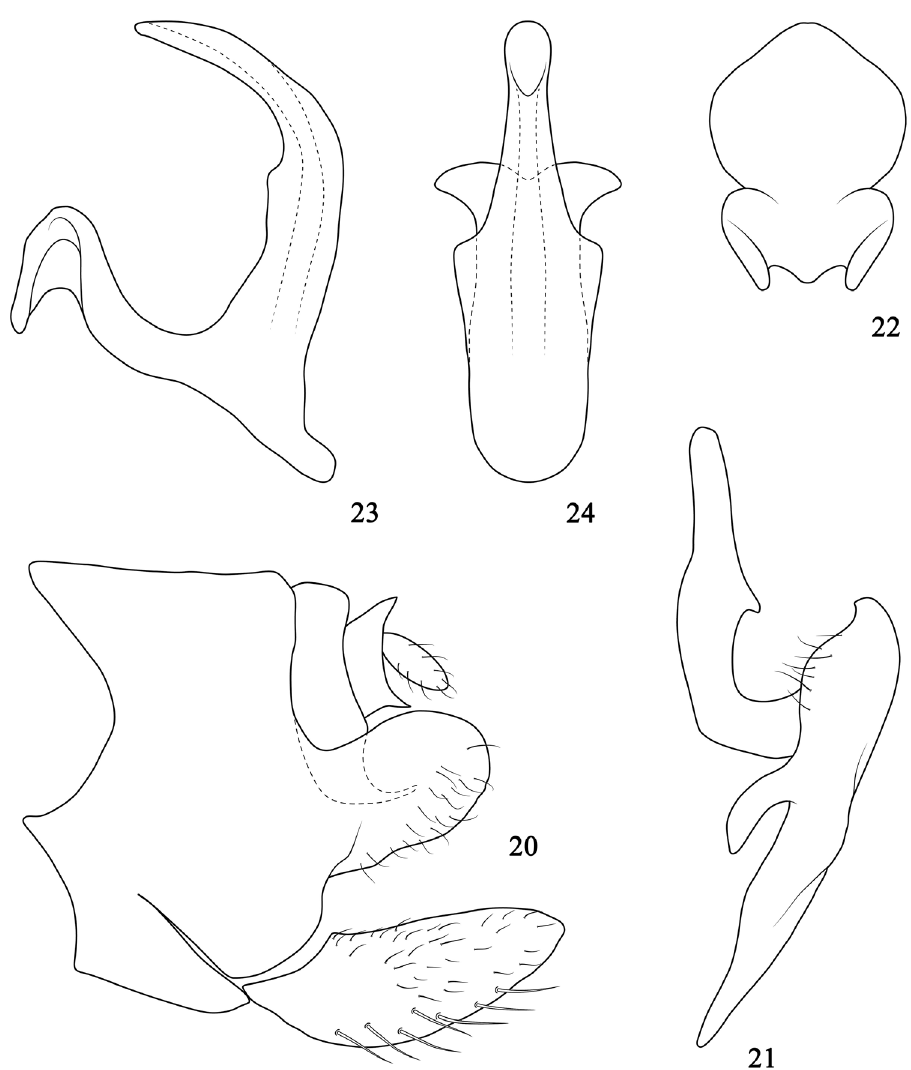
Key to species of